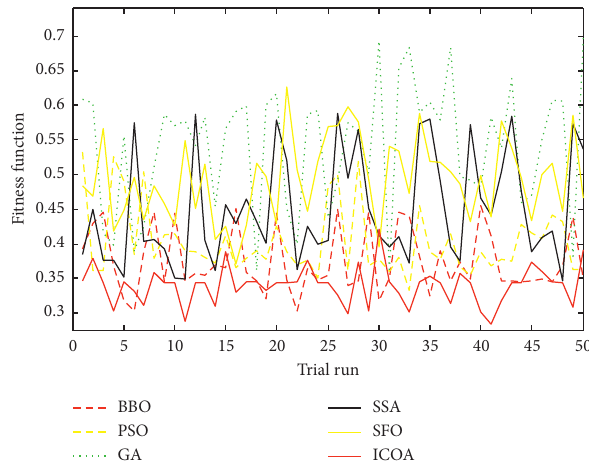
Figure 7: The fitness values of six methods in 50 trial times for the second case.